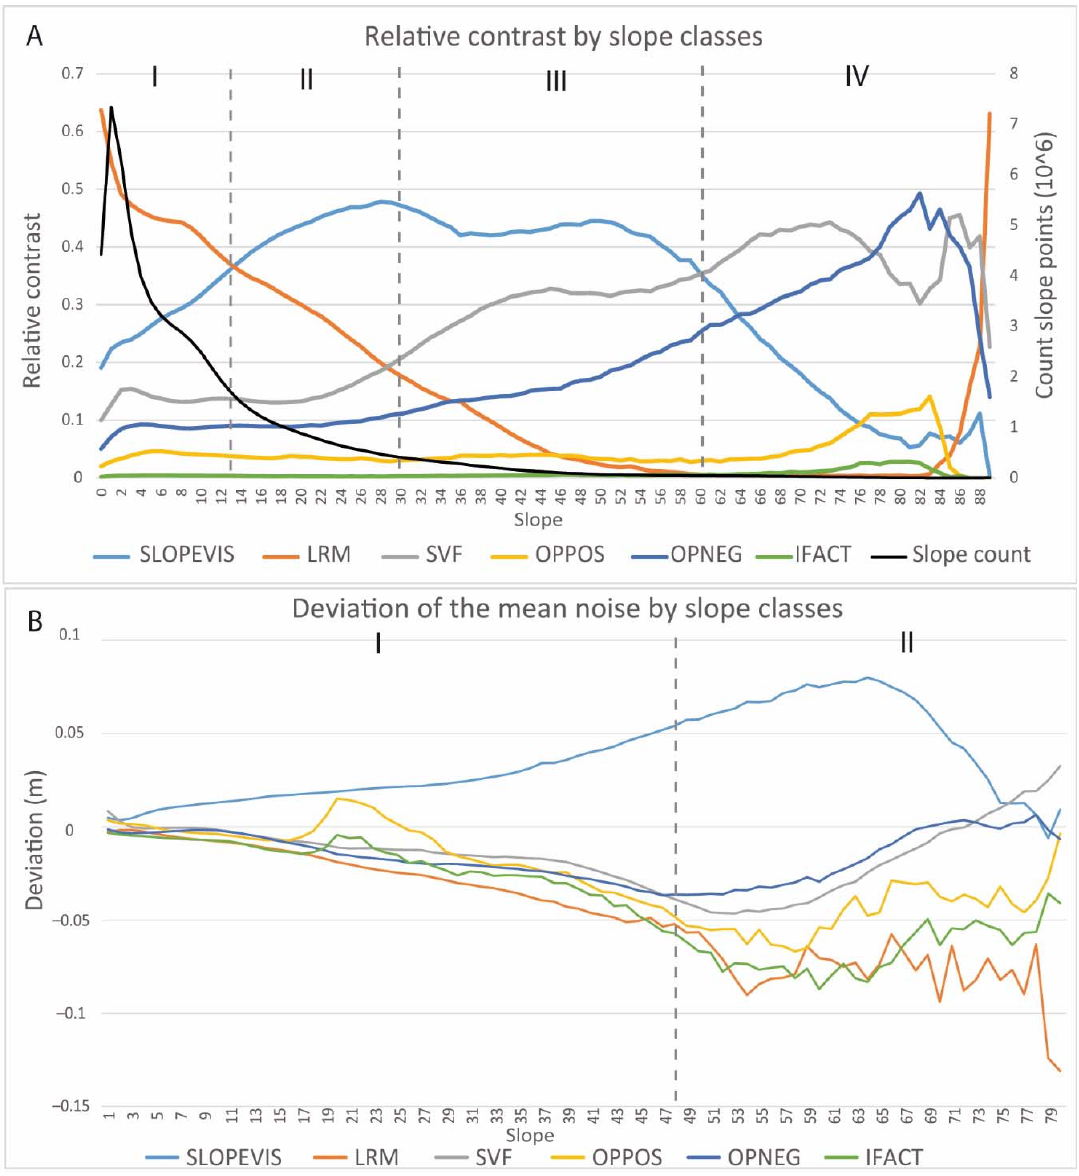
Figure 8. Contrast ( A ) and mean noise ( B ) by slope classes and VTs.